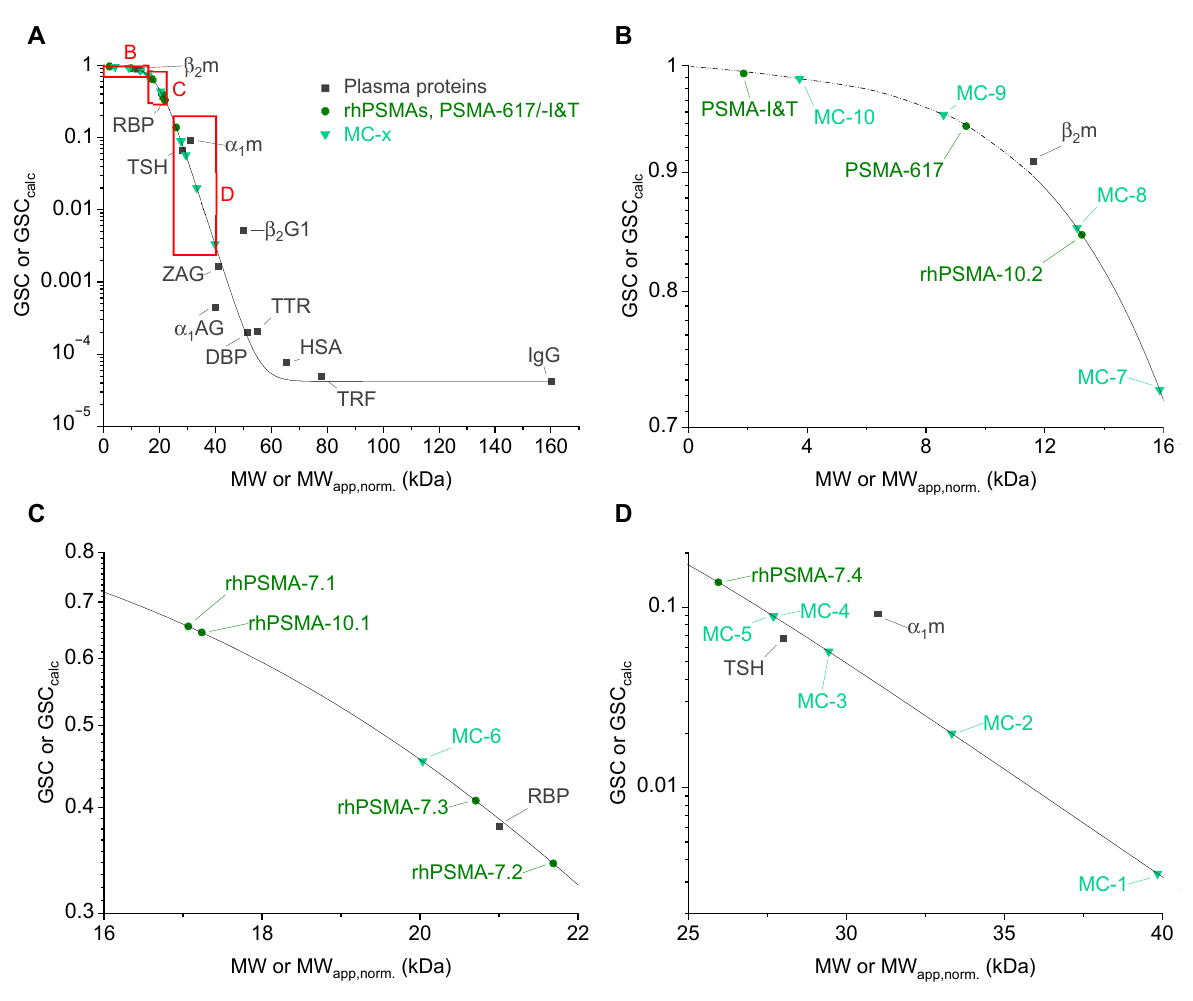
Figure 5. ( A ) Correlation between molecular weights (MWs) of plasma proteins and their glomerular sieving coefficients (GSCs, data from Norden et al. [64]). α 1AG: α 1-acid glycoprotein; α 1m: α 1- microglobulin; HSA: human serum albumin; β 2G1: β 2-glycoprotein I; β 2m: β 2-microglobulin; DBP: vitamin-D-binding protein; IgG: immunoglobulin G; RBP: retinol-binding protein; TRF: transferrin; TSH: thyroid-stimulating hormone; TTR: transthyretin; ZAG: zinc- α 2-globulin. MW app,norm. of PSMA radioligands were plotted against their respective calculated GSCs (GSC calc ). Panels ( B – D ) show different zoom-ins on PSMA radioligands, as depicted with red squares in panel ( A ). The extrapolation (dotted line) of the sigmoidal fit of GSC against MW in panel ( B ) was